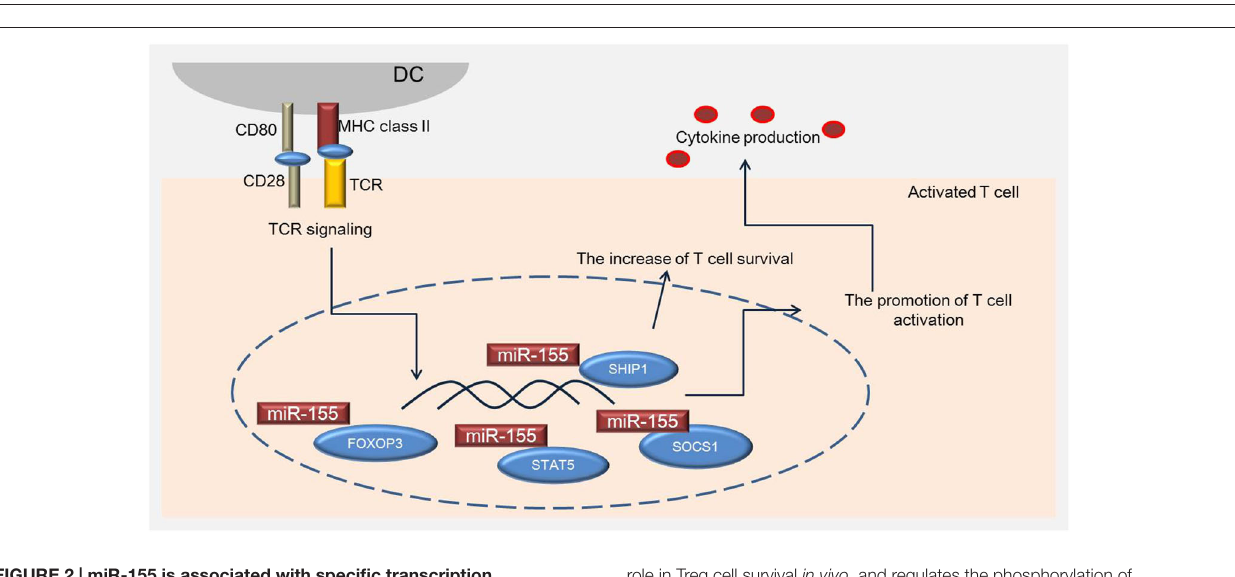
and TNF- α . miR-155 is associated with multiple process including the interaction between dendritic cells and T cells, and the regulation of Th17 and CD4+ T cell differentiation. It is also involved in regulating proliferation of Th1, Th2, and CD8+ T cells, and survival of Treg cells.